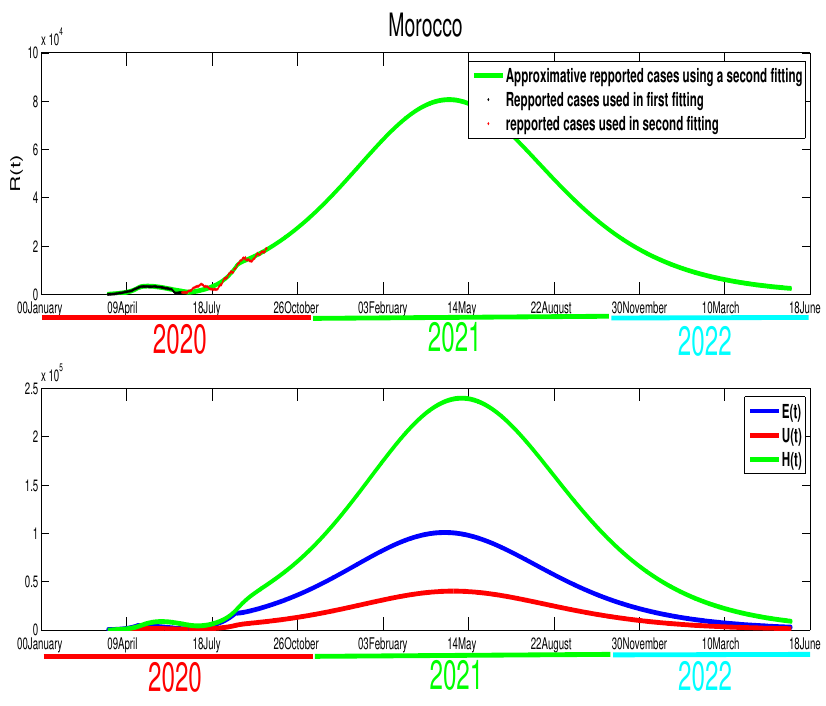
Figure 13. The projection of the number of COVID-19 cases in